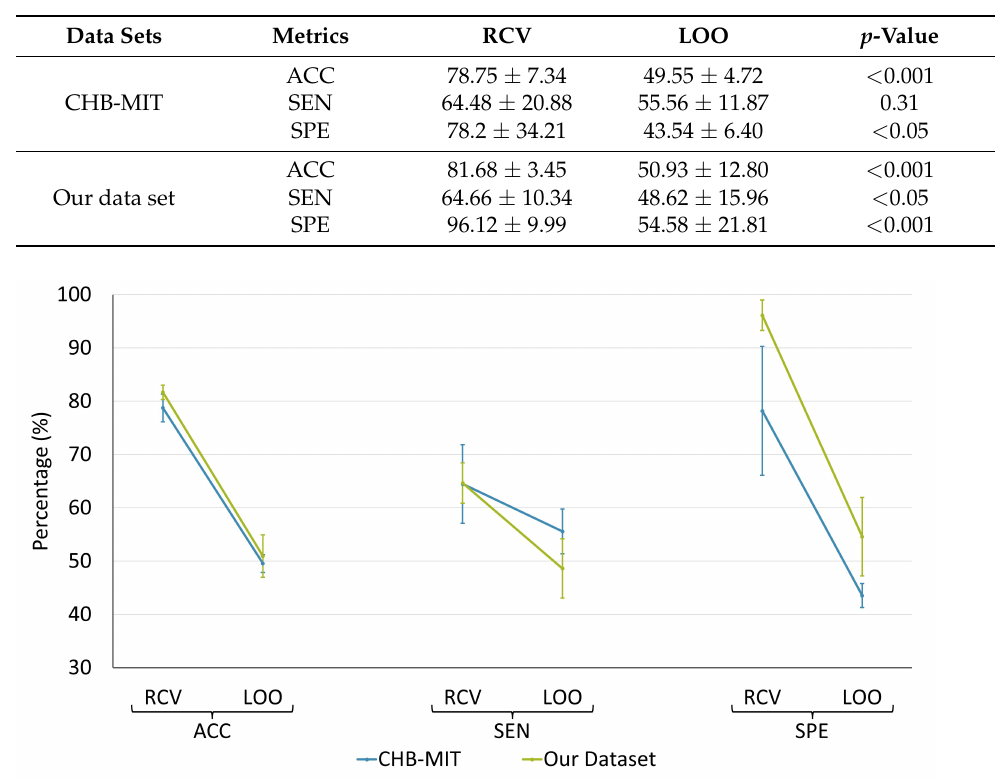
Table 5. Results of the t-test comparing RCV and LOO validation methods on the CHB-MIT data set and our data set. All performance metrics are illustrated by mean (%) ± standard deviation.